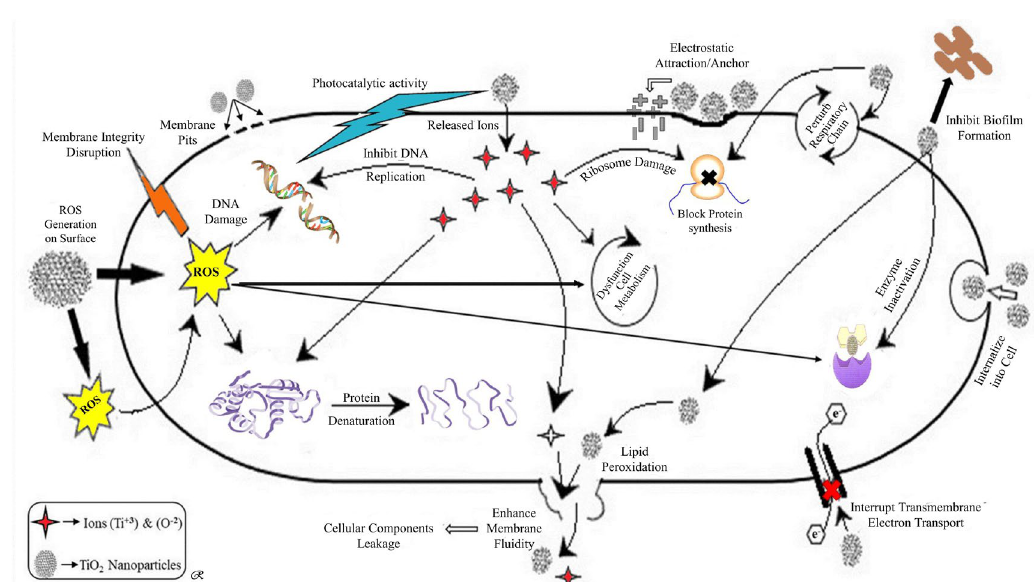
Fig. 10. Overview of Possible Antibacterial Activity Mechanisms for TiO